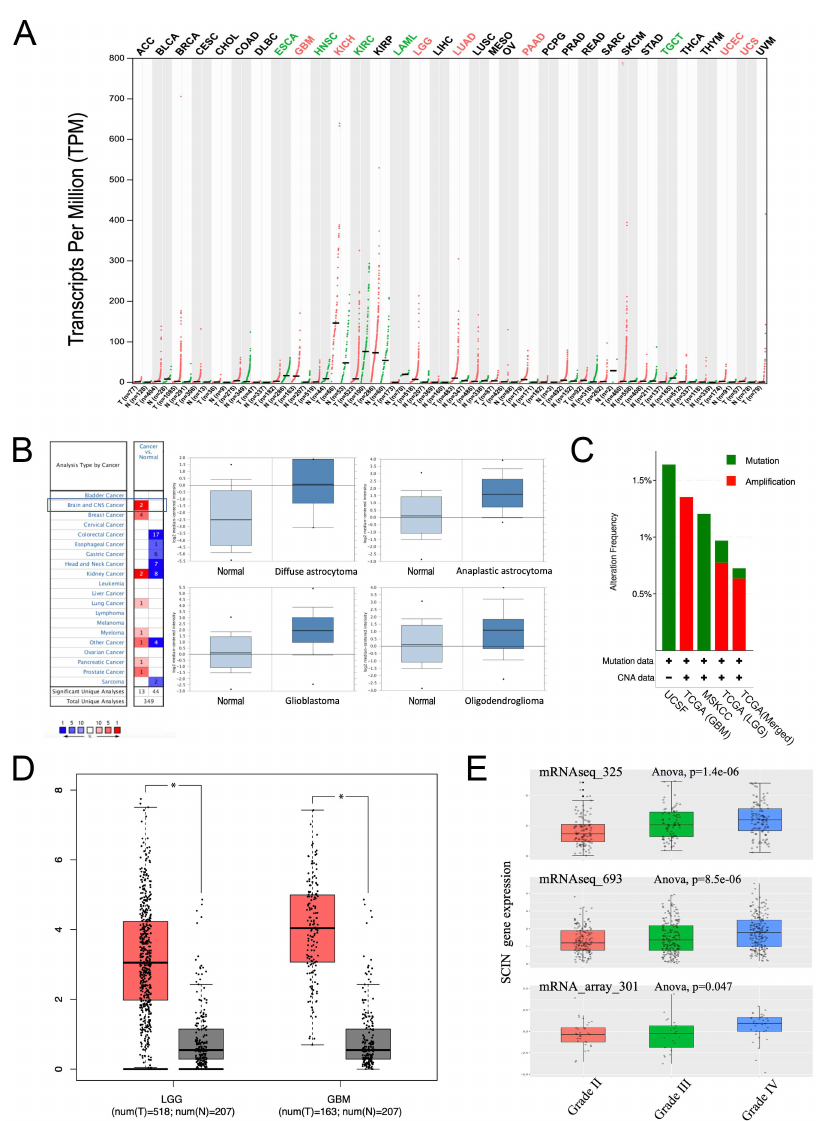
Figure 1. Scinderin (SCIN) expression is elevated in gliomas. ( A ) SCIN transcriptional expression levels in different cancers compared to normal tissues from The Cancer Genome Atlas (TCGA) and GTEx Portal databases analyzed by Gene Expression Profiling Interactive Analysis (GEPIA). There is a statistical difference (* p < 0.05). ( B ) SCIN expression level of different cancers in Oncomine Database. The left picture shows that there are two SCIN hyperexpression in the (central nervous system) CNS datasets after comparing cancerous and normal tissues. The right part is a similar analysis of samples from the Sun Brain dataset (* p < 0.05). Compared with that in normal brain tissues, the SCIN mRNA expression is higher in various glioma types, including diffuse astrocytoma (fold change = 4.522, t = 2.931, p = 0.006), anaplastic astrocytoma (fold change = 2.807, t = 3.815, p = 2.32 × 10 − 4 ), glioblastoma (fold change = 3.348, t = 5.181, p = 4.20 × 10 − 6 ), and oligodendroglioma (fold change = 1.727, t = 2.185, p = 0.017). ( C ) cBioPortal analysis of the SCIN alternation rate in glioma. ( D ) SCIN level in lower-grade glioma (LGG) and glioblastoma (GBM) compared to levels in normal brain tissues by GEPIA dataset. ( E ) SCIN expression in glioma of WHO grade II, III, and IV in Chinese Glioma Genome Atlas (CGGA) datasets. CNA, copy number